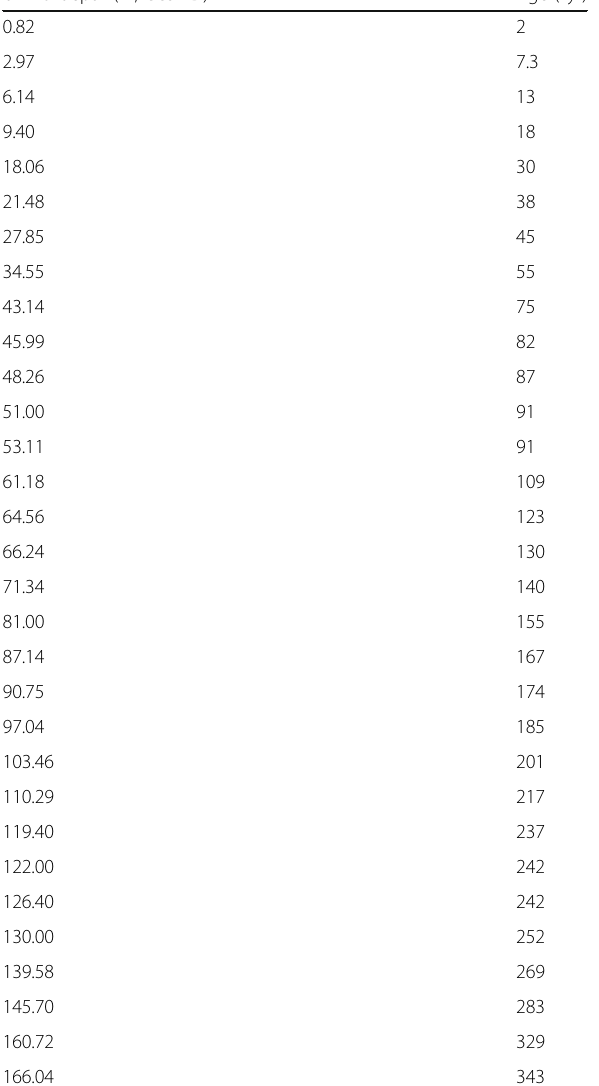
Table 2 Correlation tie points between Sites U1429 and LR04 U1429 depth (m, CCSF-D)